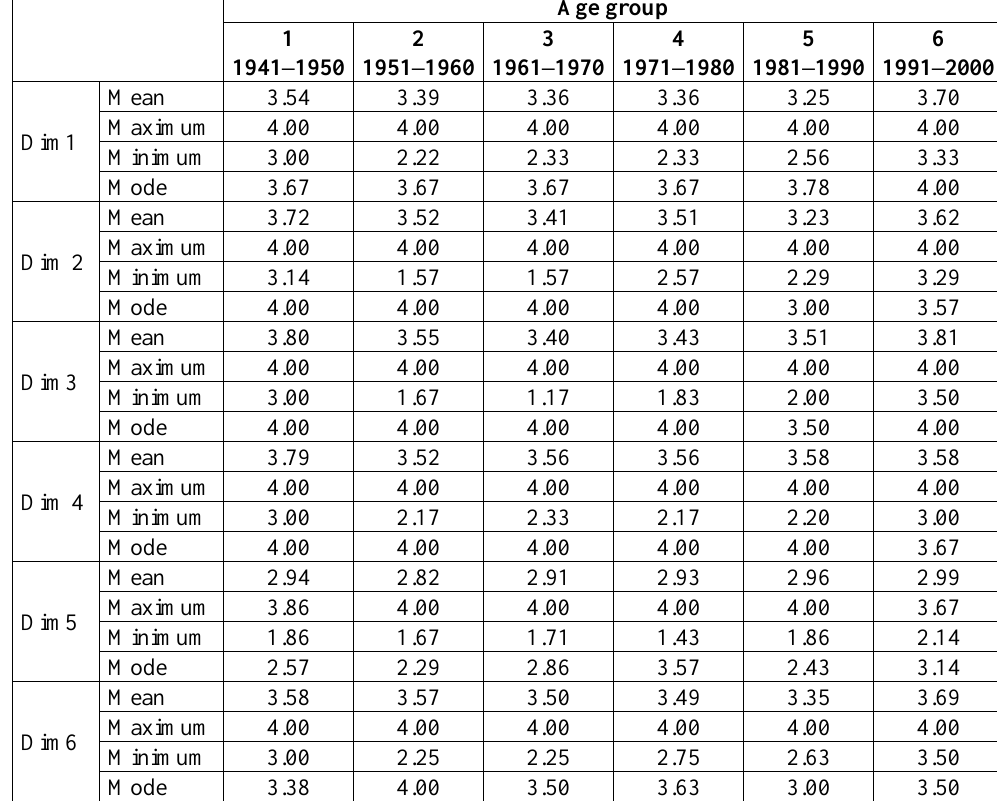
Table 5. Relationships between the Dimensions of Safety Climate and Different Age